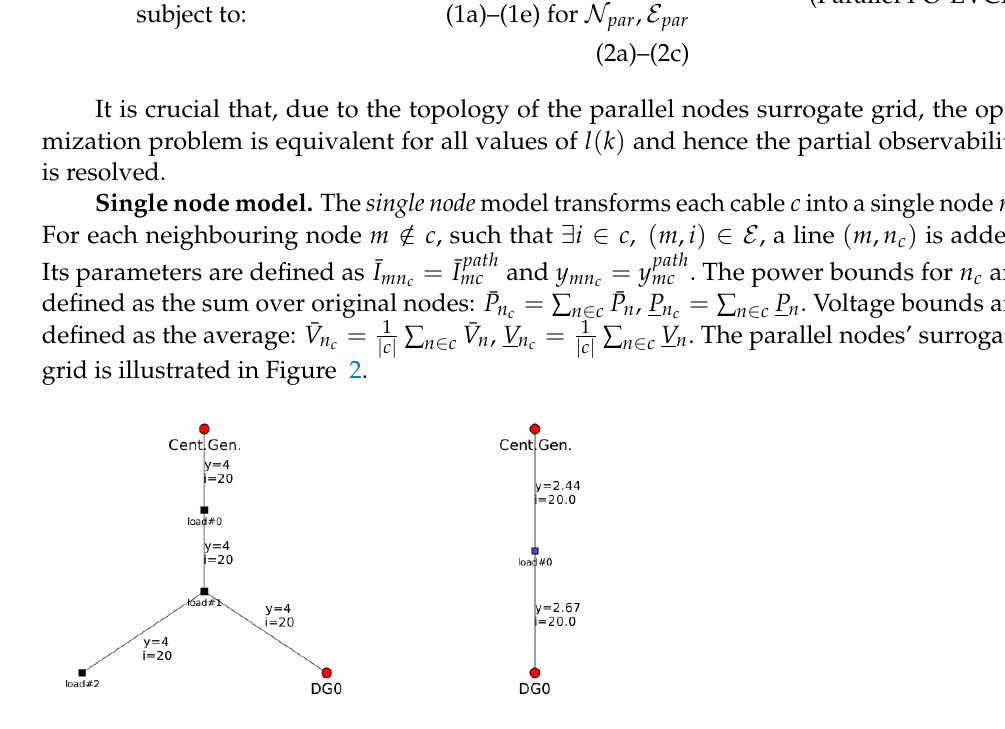
Figure 2. An example of a single node surrogate grid. Rectangular nodes are loads and red circle nodes are generators. Line capacity is denoted by y and current limit by i